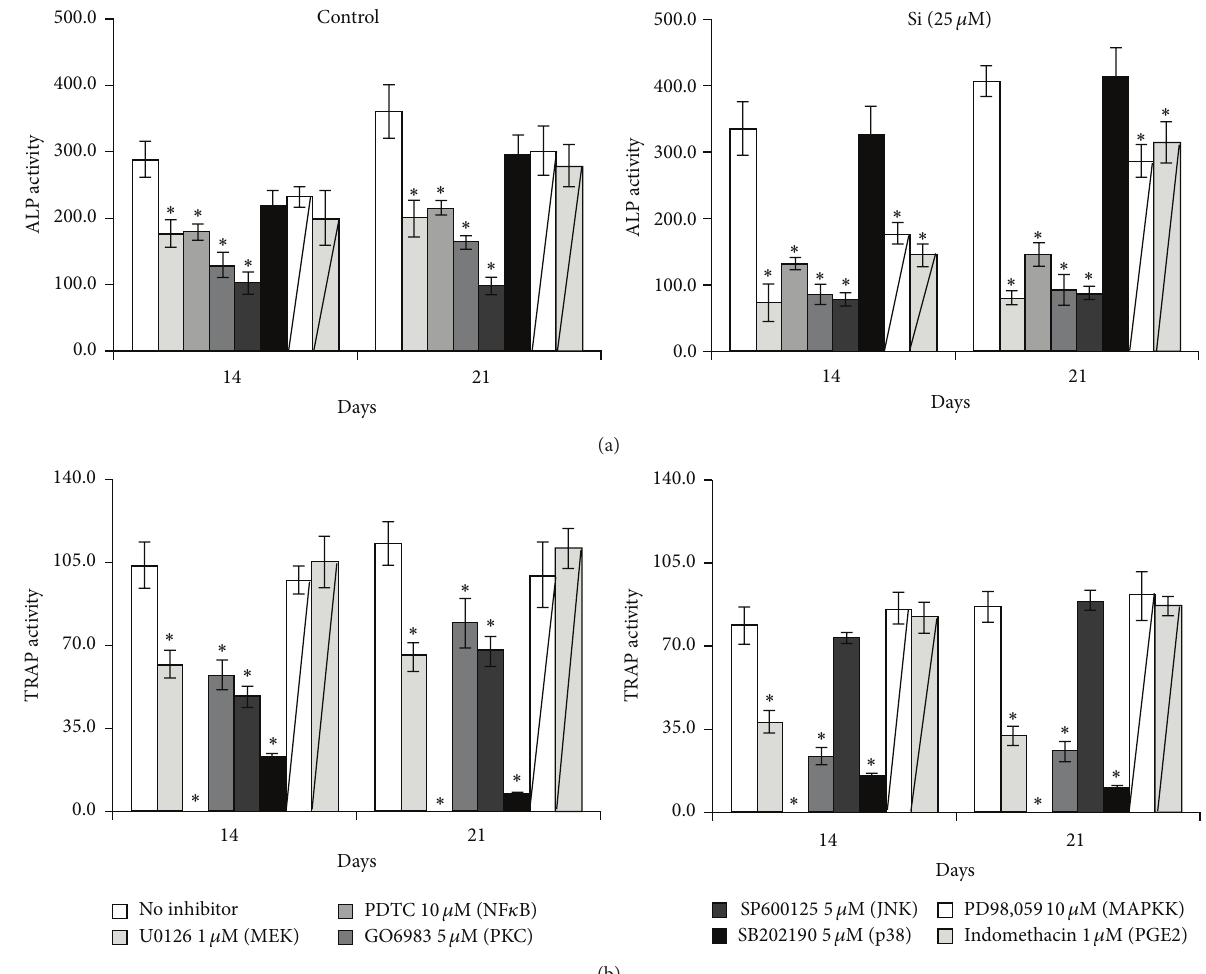
Figure 5: Modulation of intracellular signalling pathways by Si. Cell cultures were treated with several inhibitors and assessed for ALP activity (hMSC cultures, panel (a)) or TRAP activity (CD14+ cell cultures, panel (b)). ∗ Significantly different from the absence of inhibitors. Black arrows represent the main differences observed in Si-treated cultures, compared to the corresponding negative controls (absence of